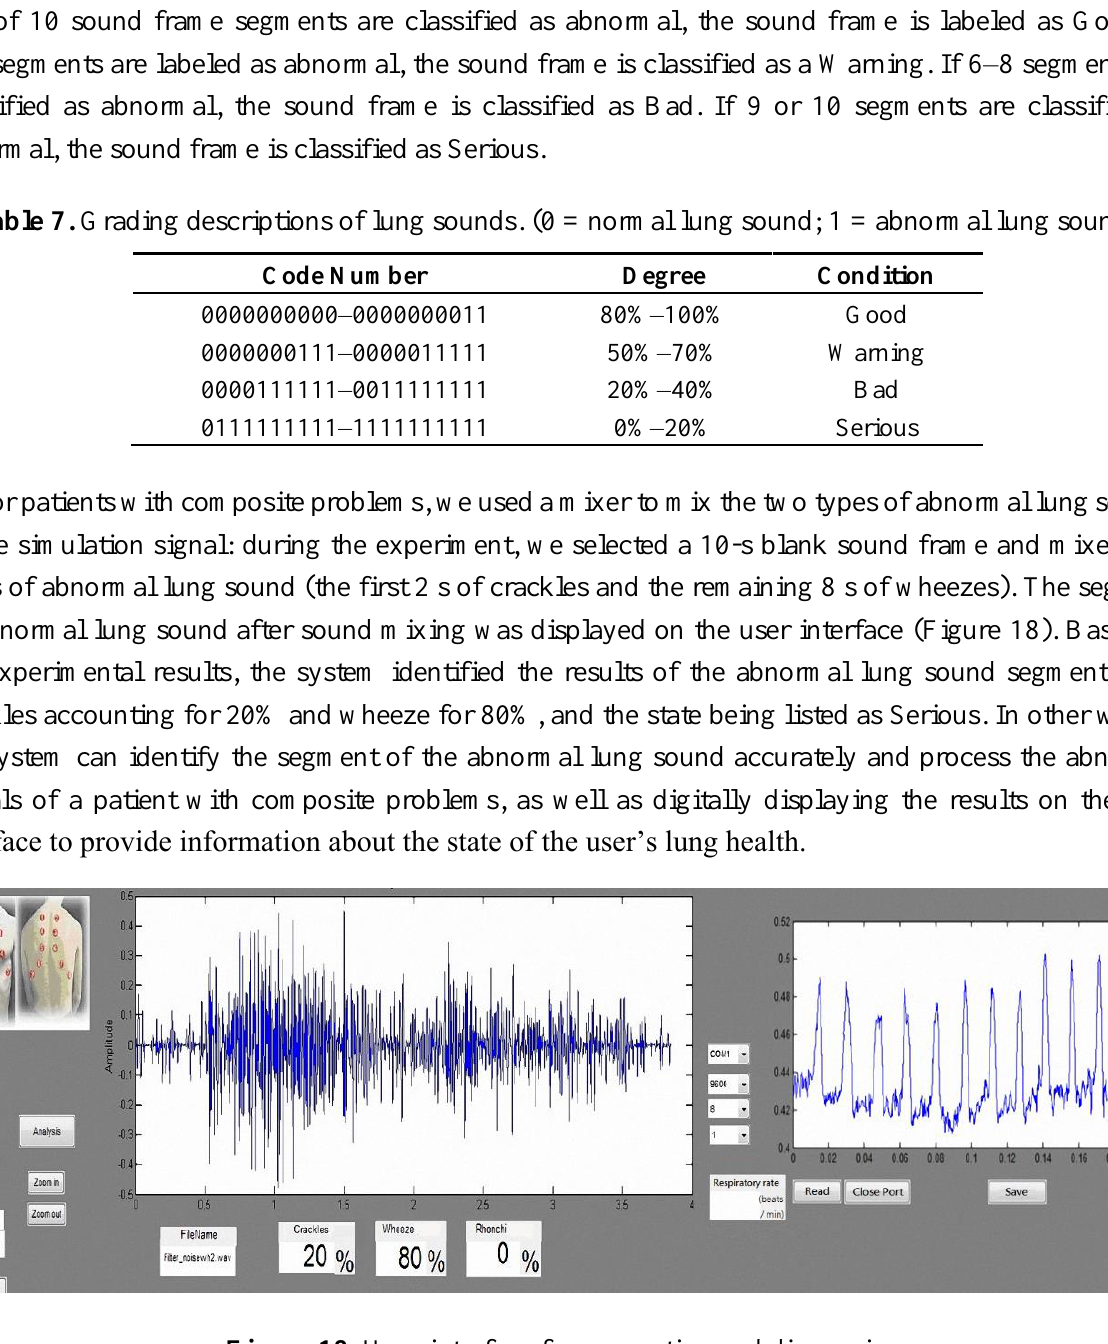
Figure 18. User interface for prevention and